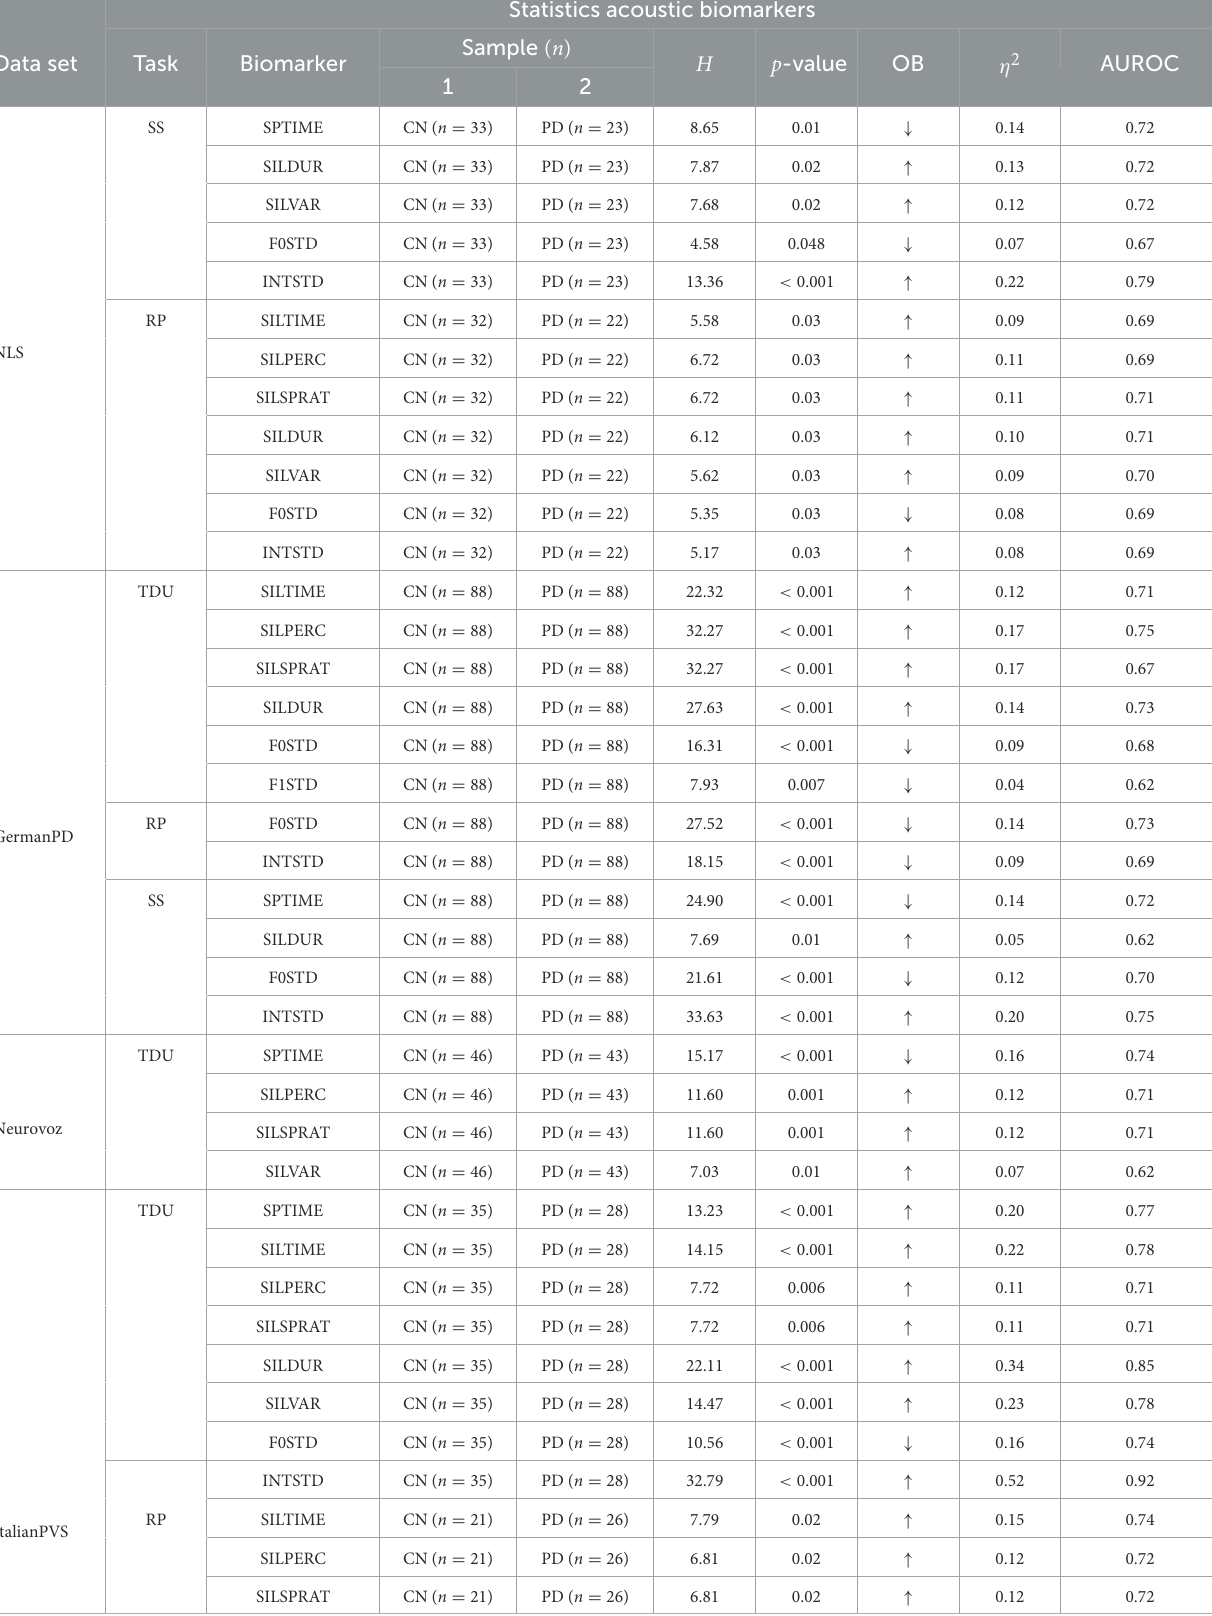
TABLE 5 Pairwise Kruskal–Wallis H -test results for the acoustic biomarkers that were statistically significant ( p < 0.05) in the TDU, RP, and SS tasks, respectively, within the six data sets